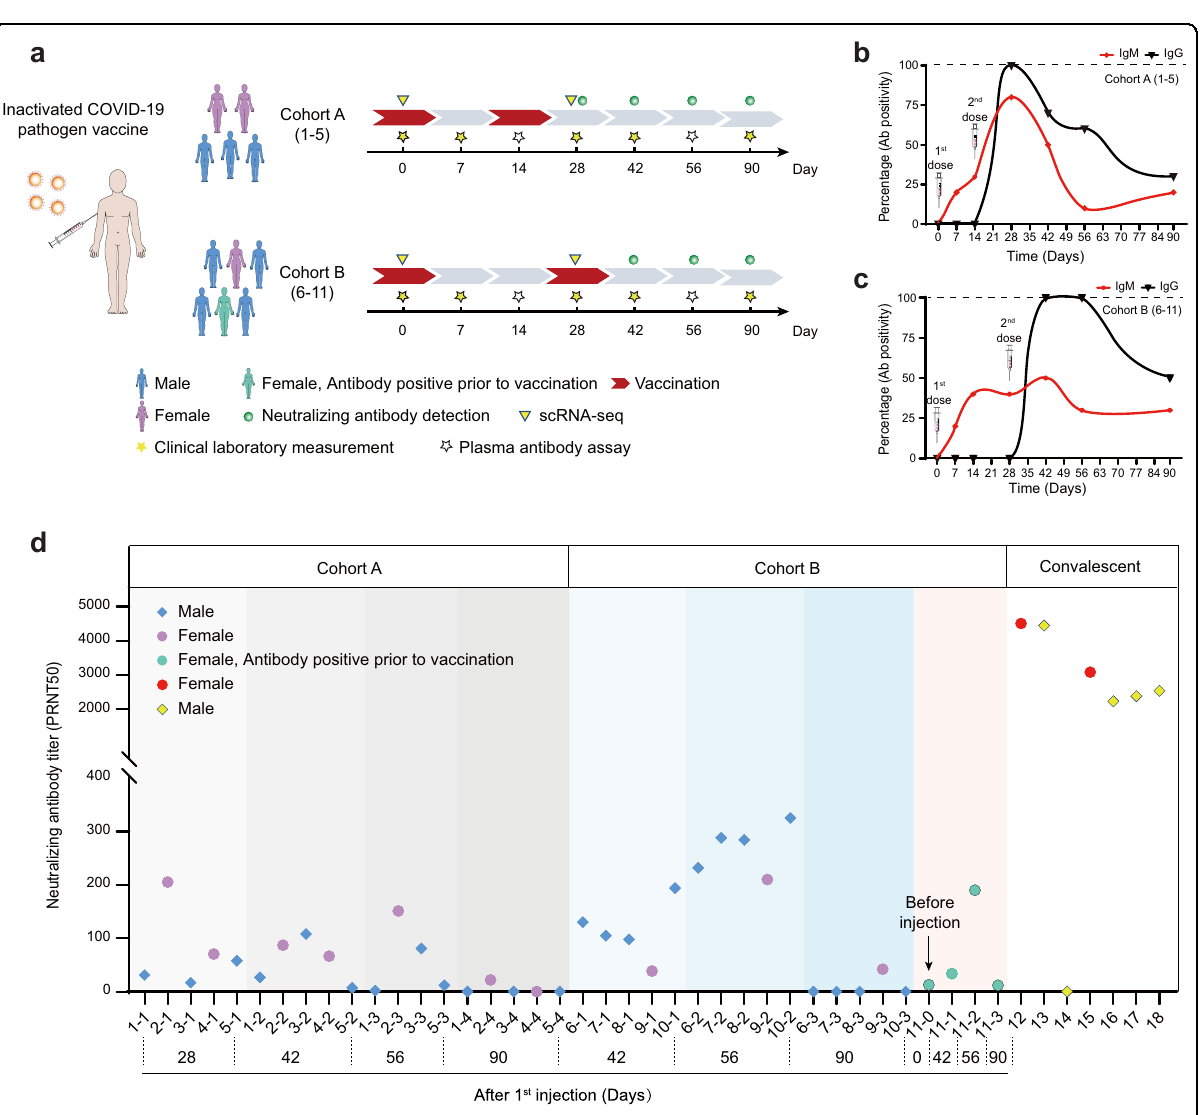
Fig. 1 Schematic work fl ow and SARS-CoV-2 antibody/neutralizing antibody detection after vaccination. a Schematic description of vaccine inoculation strategies, blood sample collections, and measurements. b , c Antibody positivity changes (percent positive/total) over time in cohorts A and B. Volunteers in cohort A were inoculated on days 1 and 14, and in cohort B, on days 1 and 28. Red line represents IgM changes, and black, IgG. d Neutralizing antibody titer changes in plasma of volunteers in cohorts A and B after vaccination, as well as those from convalescent individuals